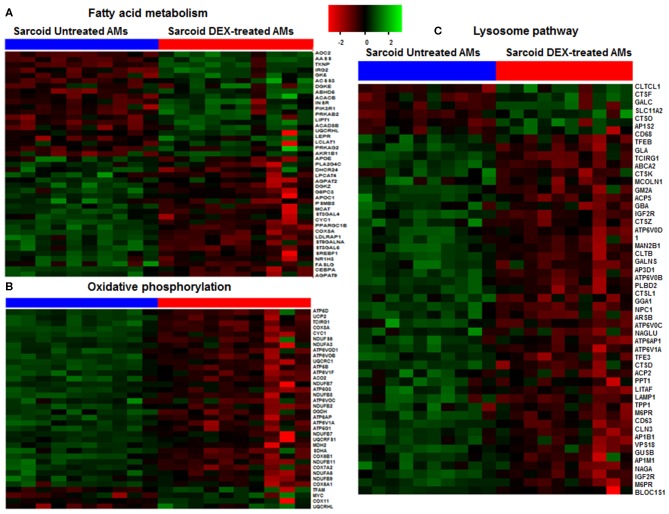
Heat map of DE genes involved in fatty acid metabolism, oxidative phosphorylation and lysosomal pathways. (A) Fatty acid metabolism, (B) Oxidative phosphorylation, (C) Lysosomal pathway. The thresholds used to select the DE genes: log2 FC > 0.6 and FDR < 5%. Green shade represents high expression and red shade represents low expression.